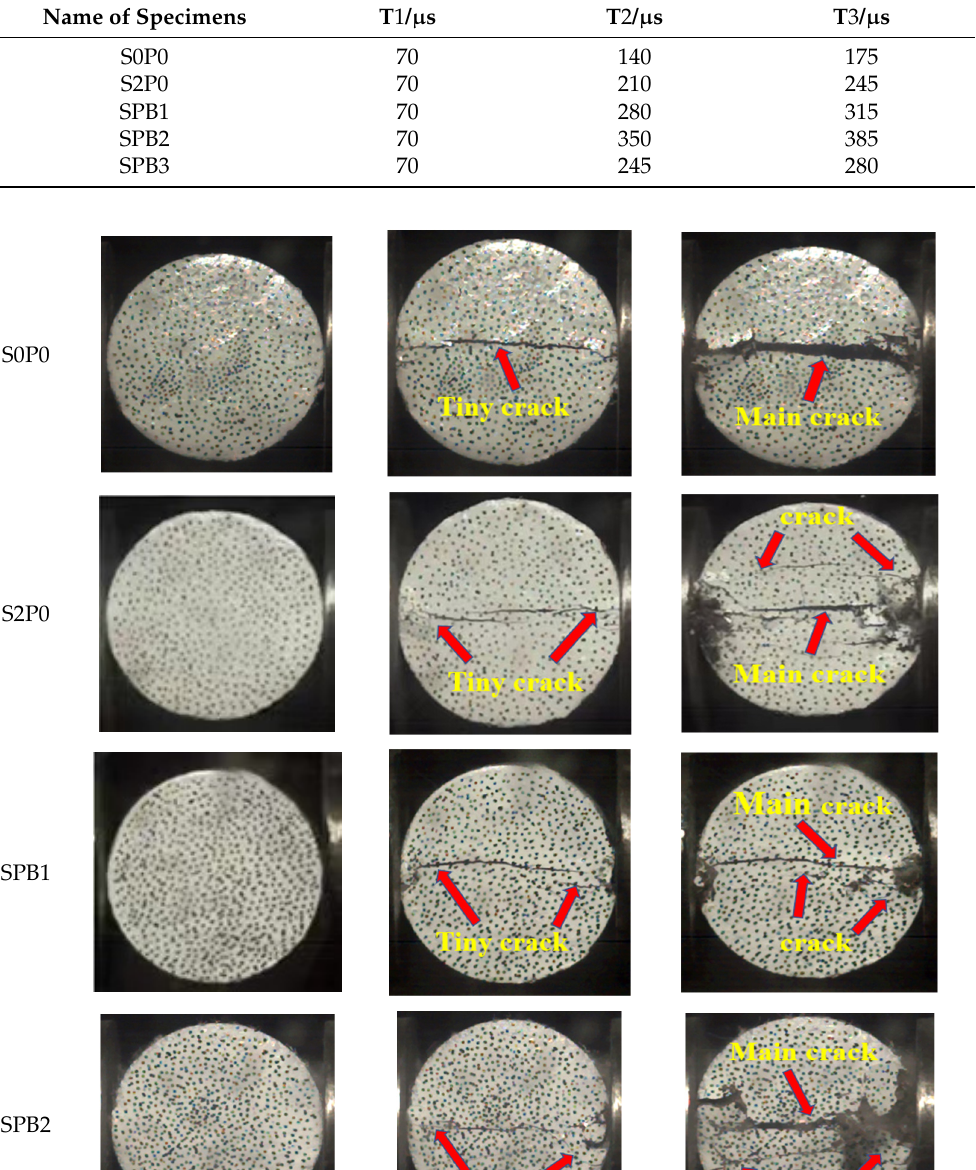
Table 8. The corresponding schedule of DIC strain nephograms for each group of specimens.